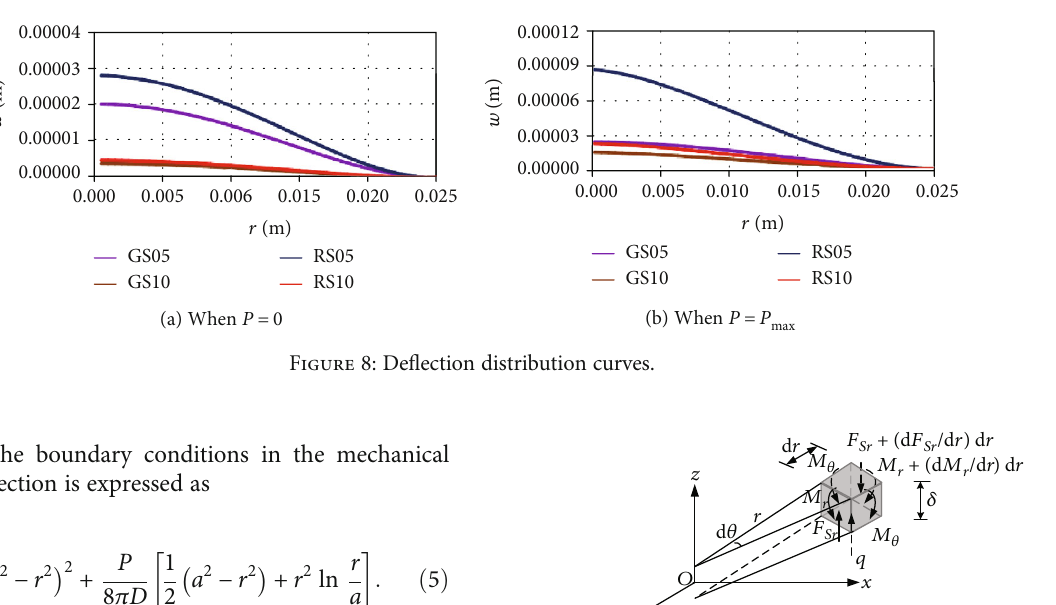
Figure 7: Bending failure patterns.